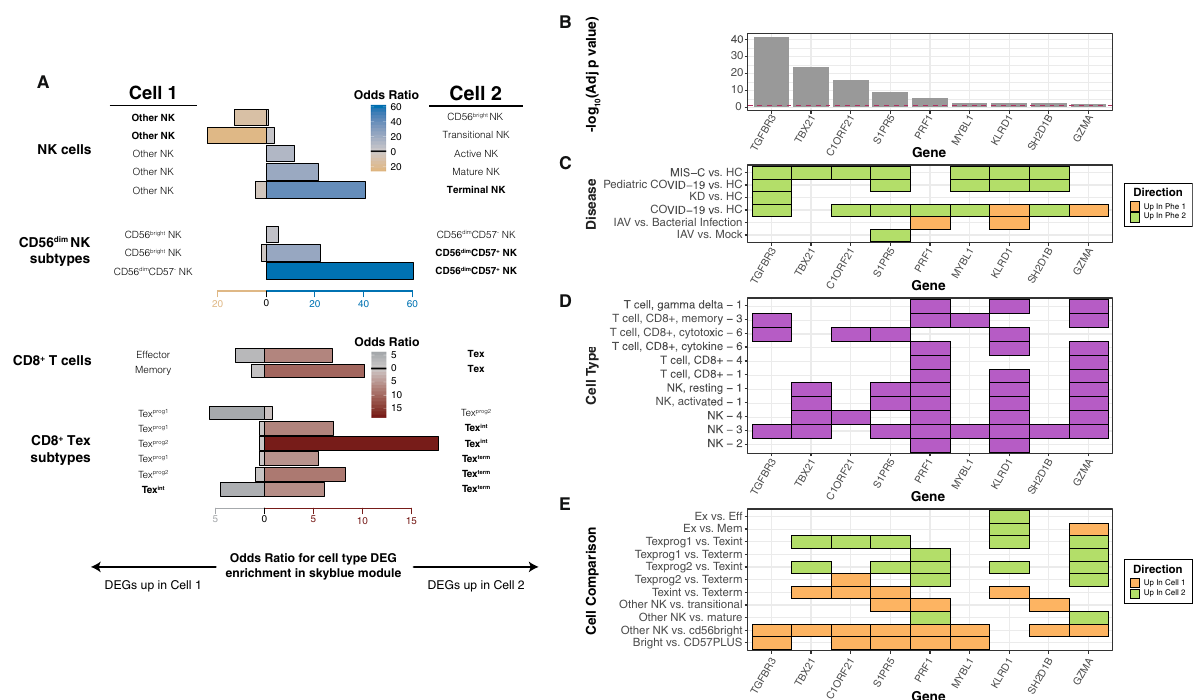
Fig. 5 Further dissection of skyblue implicates cytotoxic lymphocyte subtypes in MIS-C. A De fi ning NK cell and CD8 + T cell subtypes in skyblue (Supplementary Data 19). The x -axis represents the OR for the enrichment of skyblue for speci fi c cytotoxic cell subtypes and the y -axis the signatures used. Cell one and cell two refer to the cell subtypes being compared to generate the DE signatures projected onto skyblue and the direction of the bar is shown towards the upregulated cell type in the comparison. The color and length of bars represent the OR of the enrichment test as de fi ned by the x -axis and the legends. For NK cells, we used signatures from Yang et al., Nat. Commun. , 2019 (labeled NK cells), and from Collins et al. Cell 2019 (labeled CD56 dim NK subtypes). For CD8 + T cells, we used signatures from Wherry, et al. Immunity , 2007 (labeled CD8 + T cells), and from Beltra et al. Immunity , 2020 (labeled CD8 + Tex subtypes). Detailed descriptions of the subtypes can be found in the Methods. B – E Skyblue key drivers measures. The x-axes of the panels represent the key driver genes. B Key driver analysis results (hypergeometric test).The y -axis of this panel is the − log 10 (Bonferroni adjusted p -value) of key driver analysis (Supplementary Data 21). The red dashed line is the signi fi cance threshold at − log 10 (0.05). C Related disease differential expression. In this panel, the y -axis is the disease name corresponding to Fig. 4. The color represents the direction in the comparison as de fi ned in the legend (de fi ned per the associated reference). D Cell-type-speci fi c expression of key driver genes (Supplementary Data 22). The y -axis is the cell type signatures from the following references: 1 = Newman et al. Nature Methods, 2015; 2 = Park et al. Science, 2020; 3 = Wilk et al. Nature Medicine, 2020; 4 = Liao et al. Nature Medicine, 2020; and 6 = Szabo et al. Nature Communications, 2019. E CD8 + T cell and NK cell subtype-speci fi c signatures. The y - axis is the cell-type name corresponding to A and the color represents the direction in the comparison as de fi ned in the legend (de fi ned per the associated